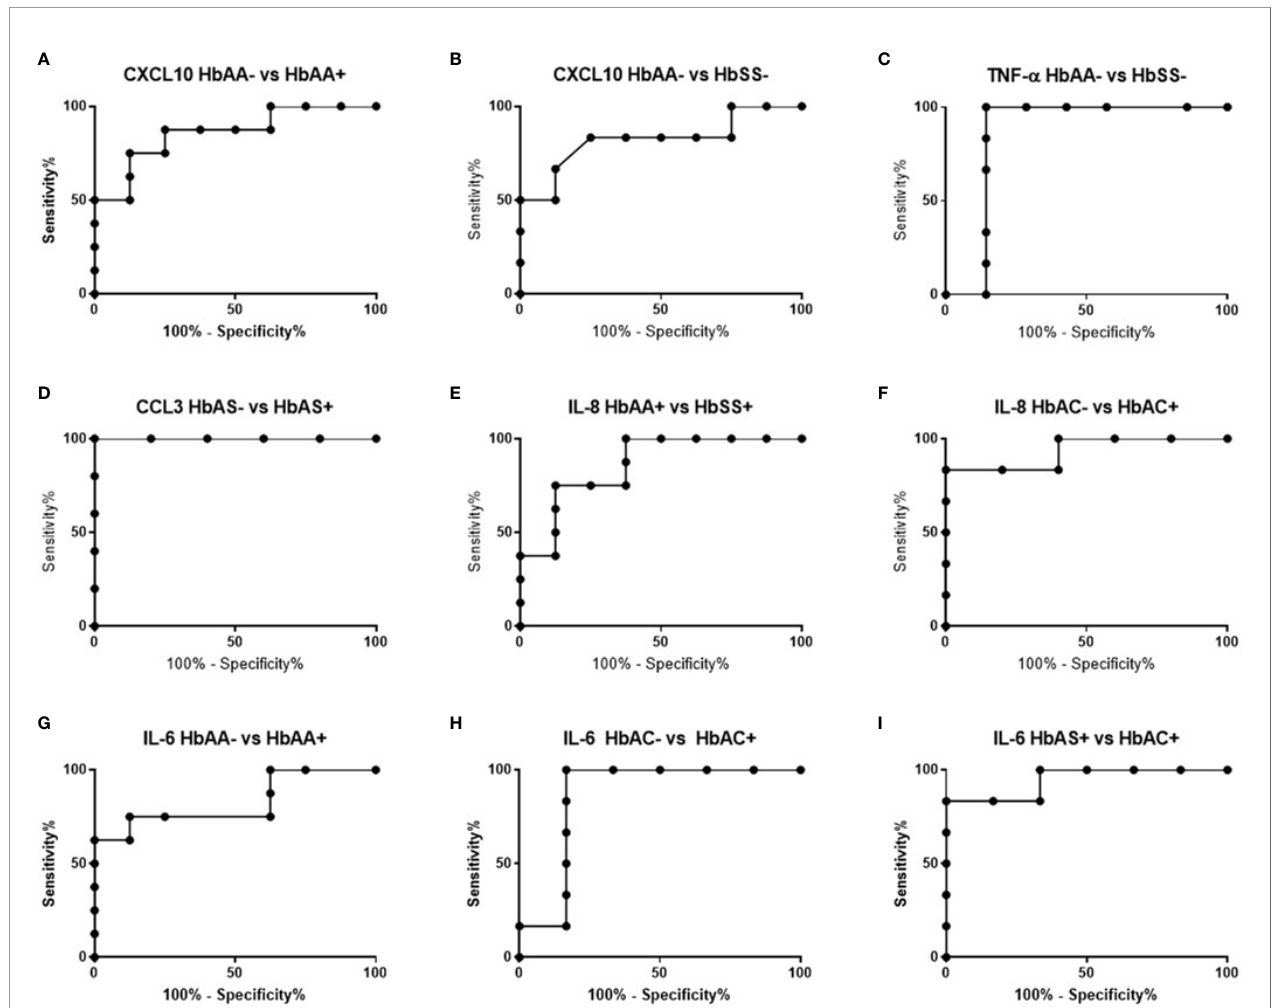
FIGURE 2 | ROC analysis. (A) CXCL10; HbAA- vs HbAA+ (P = 0.02, AUC = 0.86). (B) CXCL10; HbAA- vs HbSS- (P = 0.05, AUC = 0.83). (C) TNF- a ; HbAA vs HbSS- (P = 0.03, AUC = 0.86). (D) CCL3; HbAS- vs HbAS+ (P = 0.009, AUC = 1). (E) IL-8; HbAA+ vs HbSS+ (P = 0.02, AUC = 0.85). (F) IL-8; HbAC- vs HbAC+ (P = 0.02, AUC = 0.93). (G) IL-6; HbAA- vs HbAA+ (P = 0.03, AUC = 0.83). (H) IL-6; HbAC- vs HbAC+ (P = 0.04, AUC = 0.86). (I) IL-6; HbAS+ vs HbAC+ (P = 0.01, AUC =